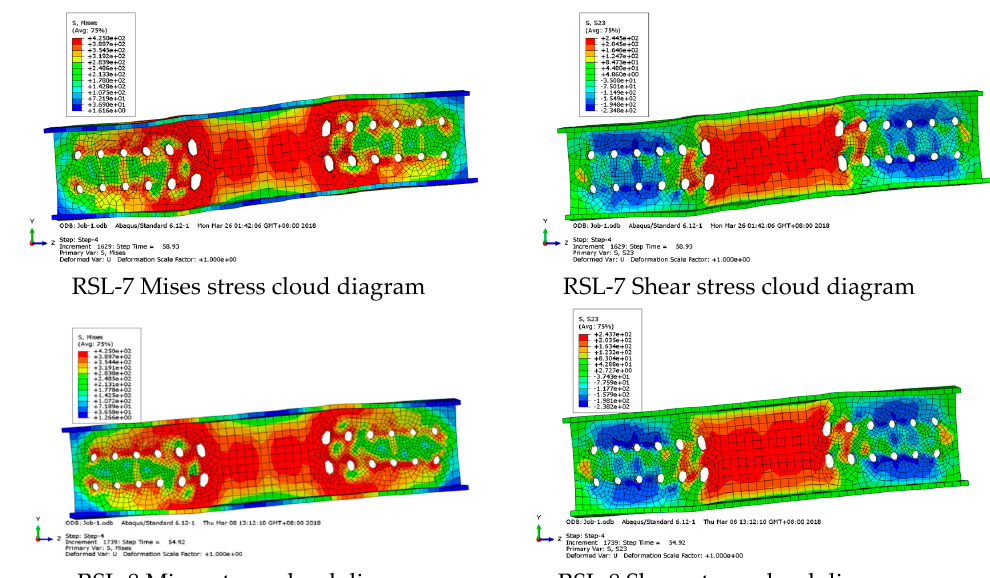
Figure 17. Stress cloud diagram of each specimen under cyclic load.